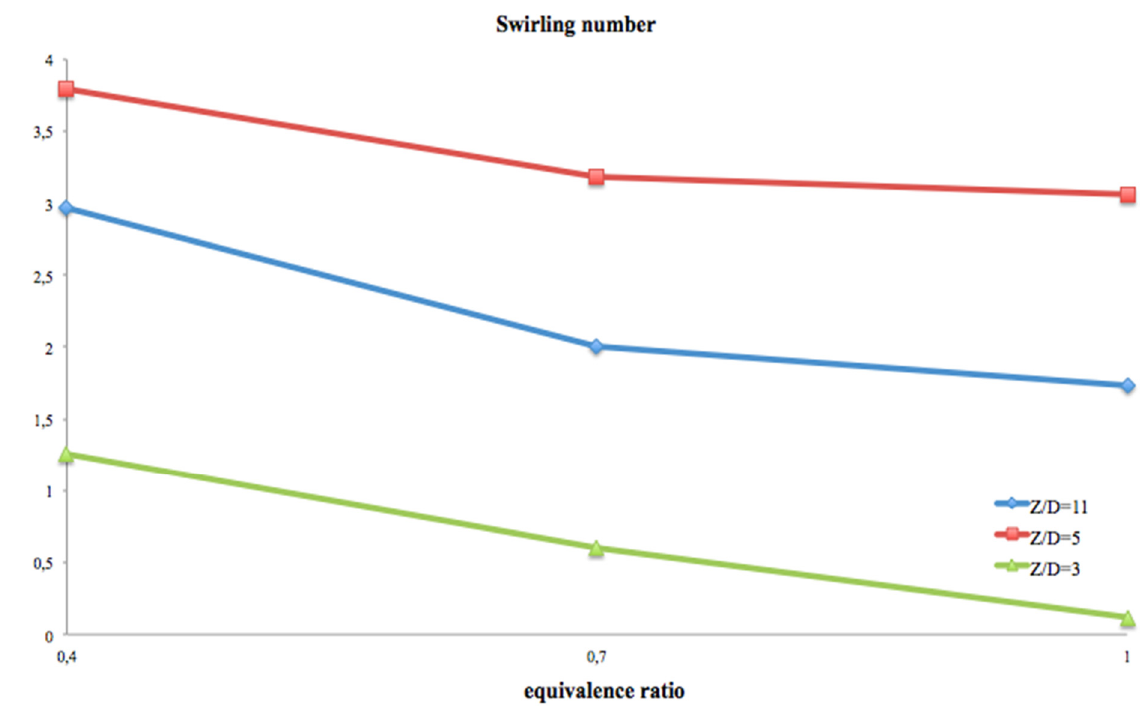
Figure 8. Swirling